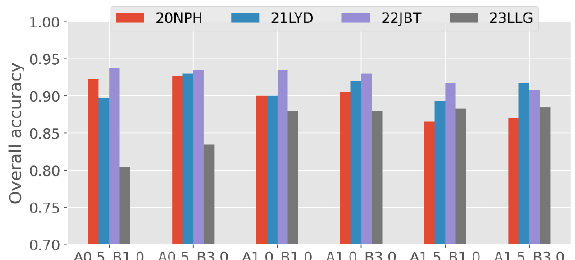
Figure 2 Overall accuracy for different A and B parameters combinations in ATSA algorithms considering three classes: Cloud, Cloud shadow, and